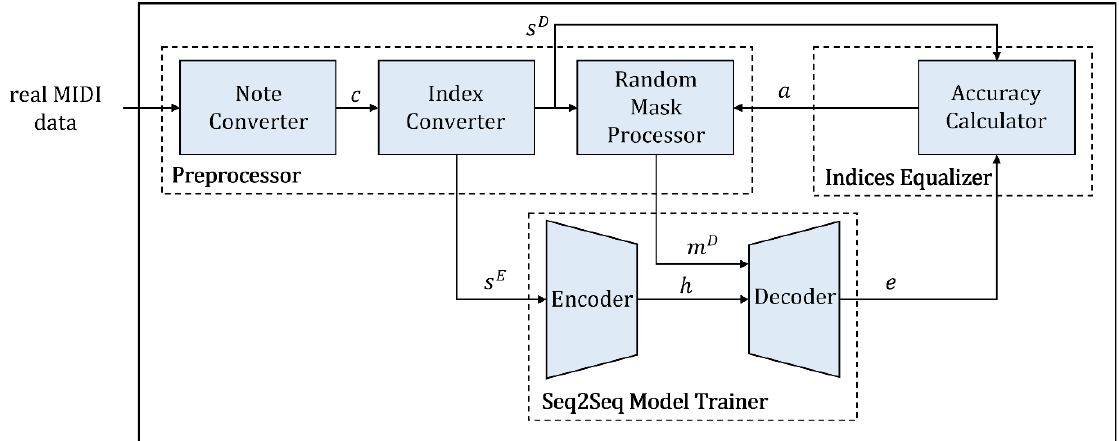
Figure 1. Training phase of the enhanced evaluation method.